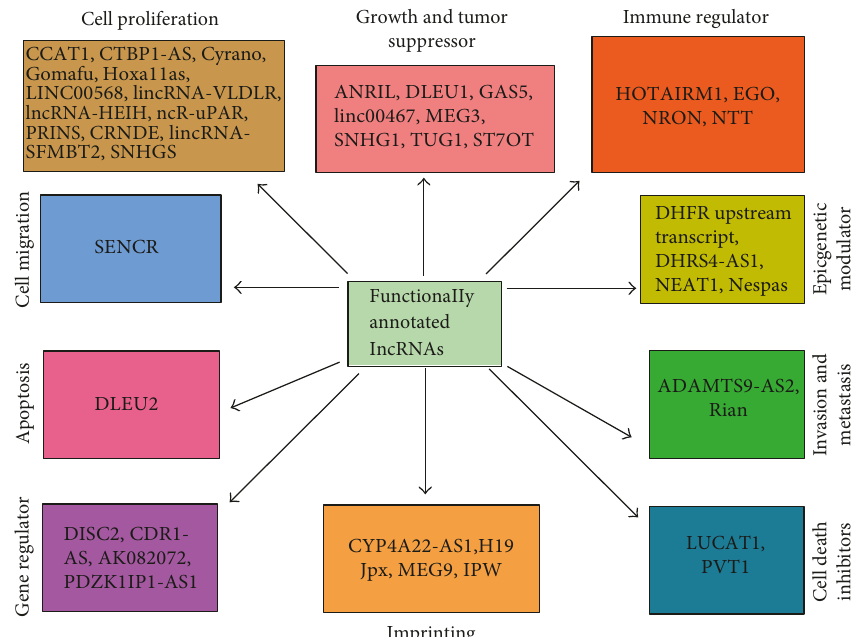
Figure 5: Identi fi cation of functionally annotated lncRNAs in HMECs treated with LPS for 3 and 24 h. Di ff erentially expressed lncRNAs belong to di ff erent categories based on publicly available databases and published